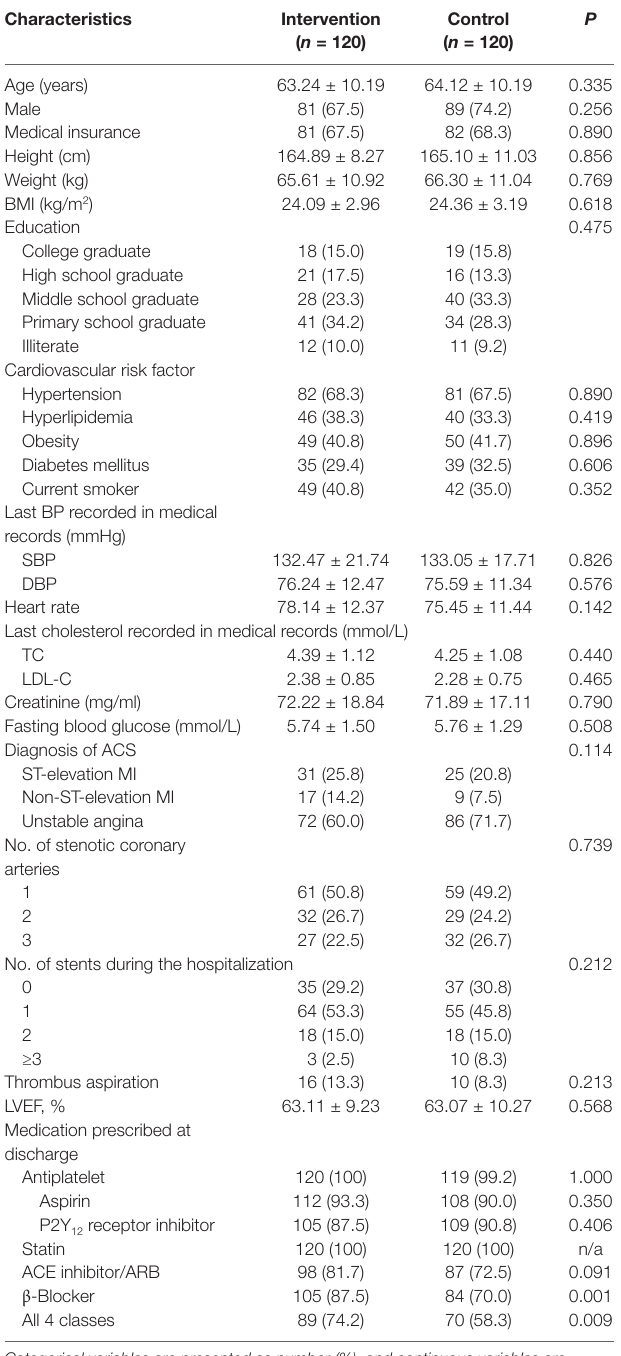
TABLE 1 | Baseline and demographic characteristics of the study patients.